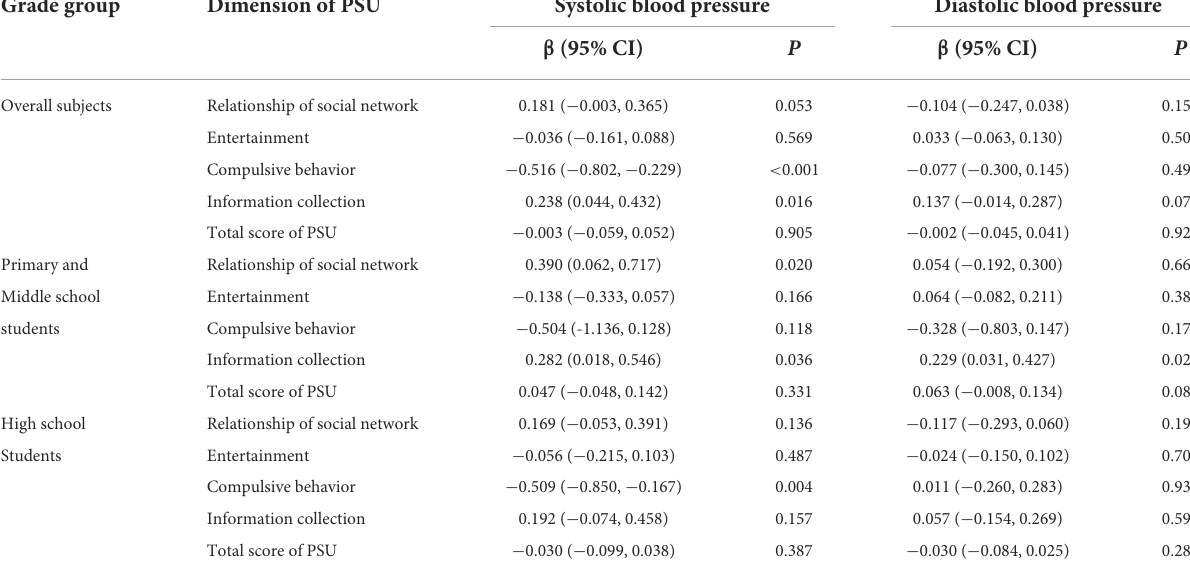
TABLE 3 Associations between PSU and blood pressure by multiple linear regression